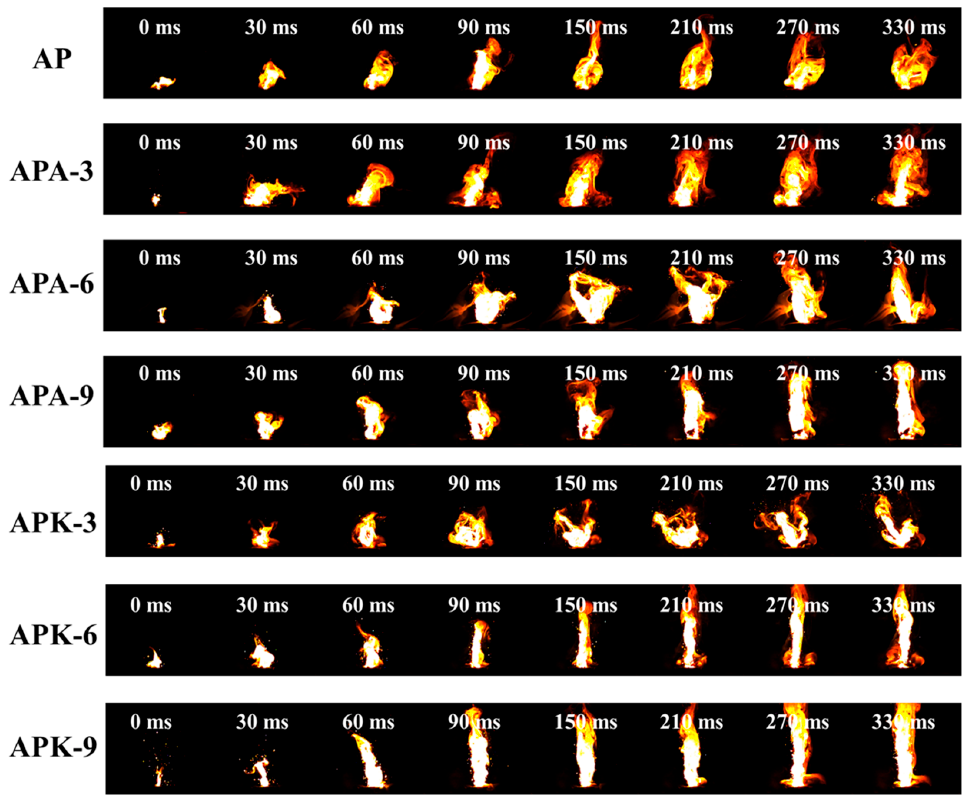
Figure 7. Ignition performance test of various samples on Nichrome wire igniter .